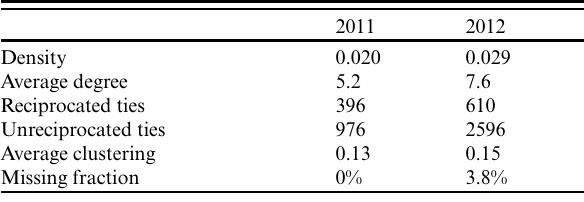
Table 2 . Change in